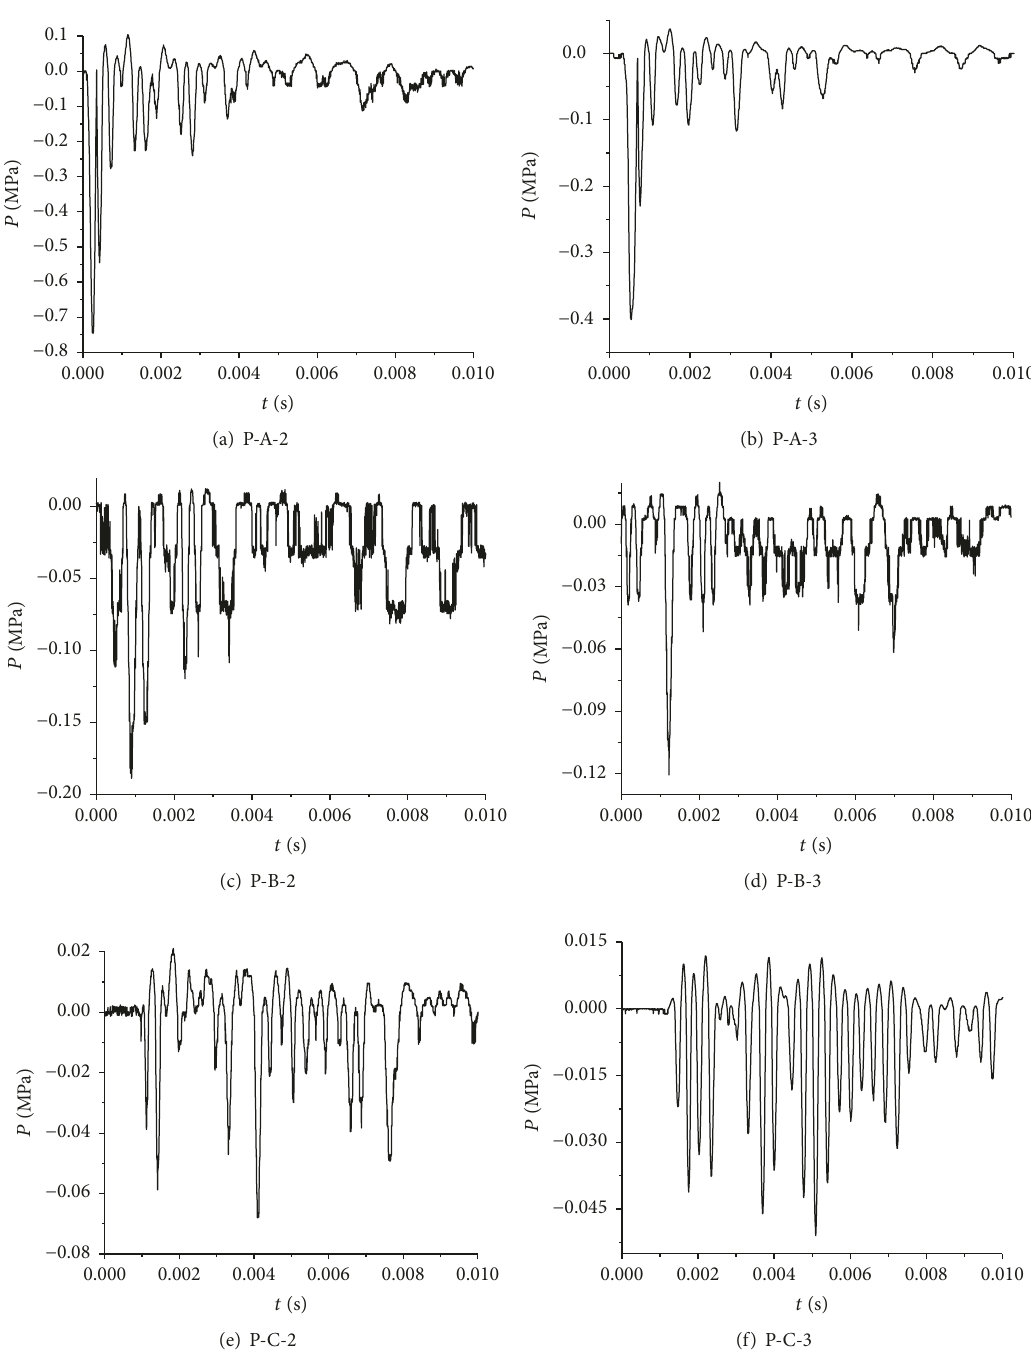
Figure 27: The contact pressure wave of two adjacent layers of Model 1 with an explosive charge quantity of 0.8 kg.